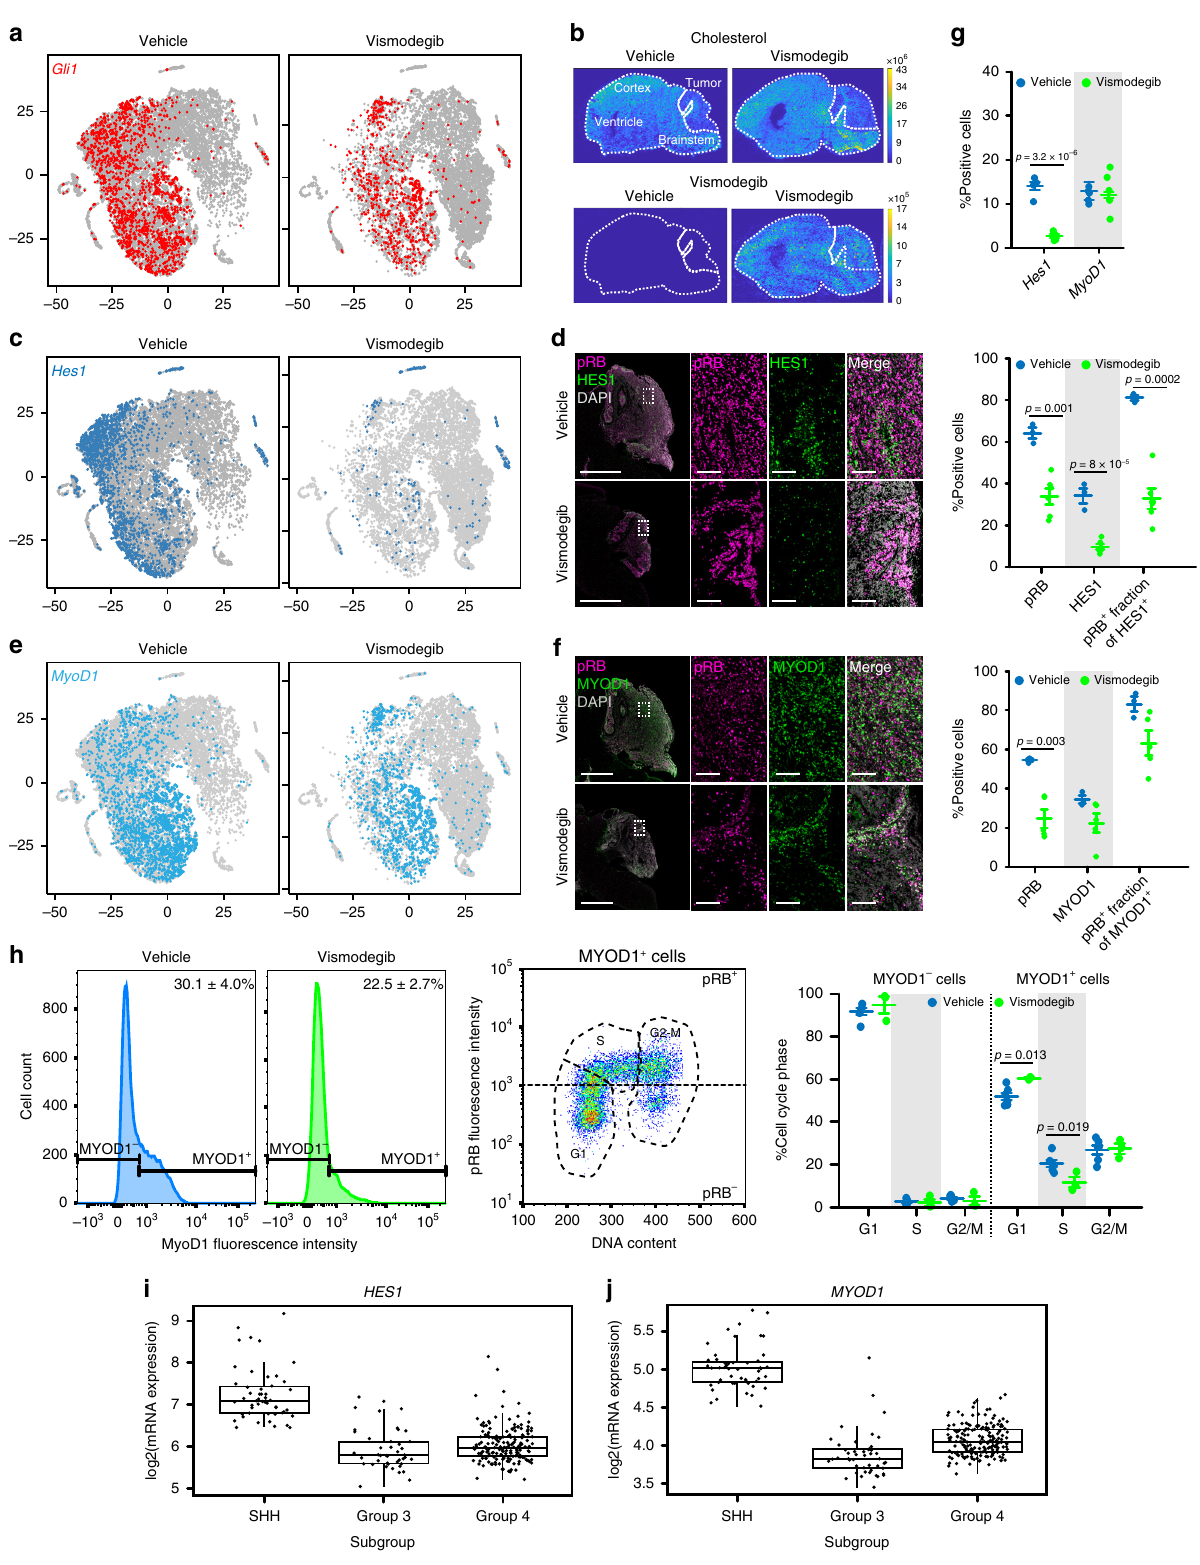
Reduced Sufu in vismodegib-resistant tumor cells . Mutations of intracellular SHH-pathway regulator Sufu can confer vismodegib resistance 25 and we therefore analyzed the effect of Sufu expres- sion on cellular response to treatment. We plotted Gli1 expression as a function of Sufu expression, and for comparison plotted the SHH target Ptch1 as a function of Gli1 . To prevent cells with